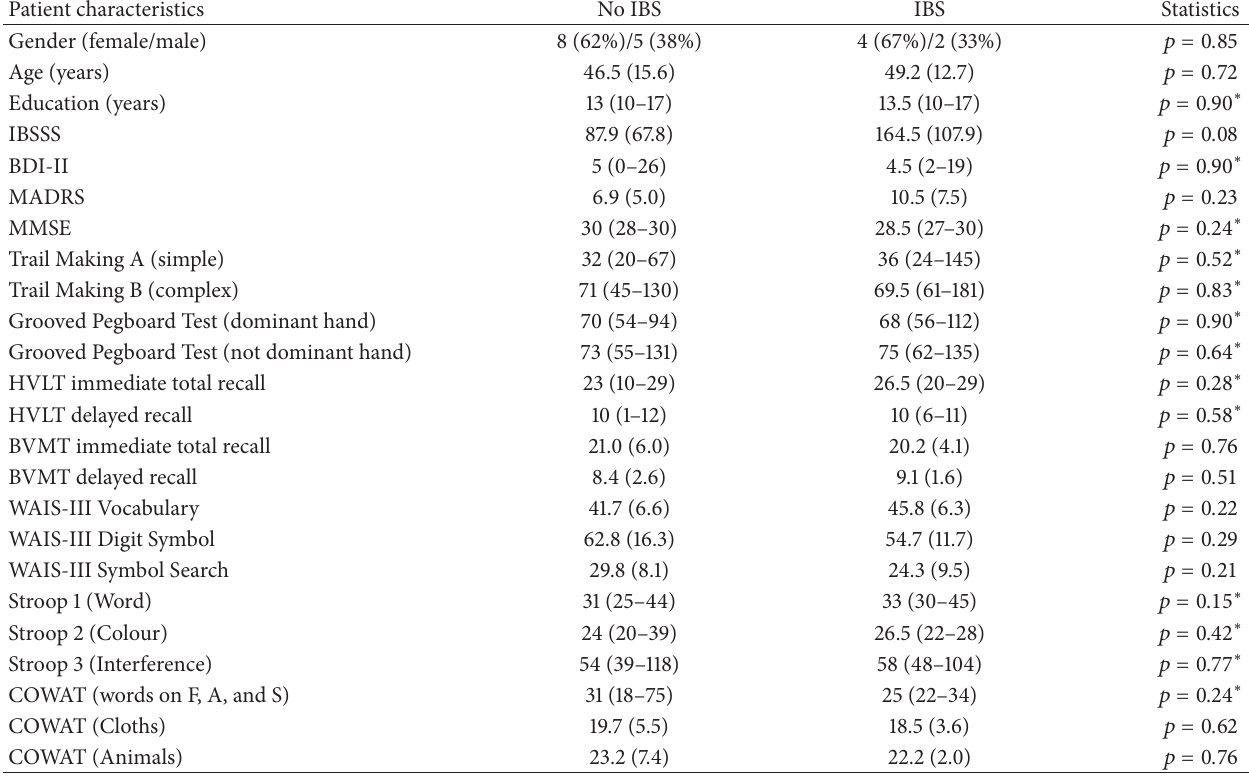
Table 2: Patient characteristics and comparisons of patients with and without IBS in the “Neurological”